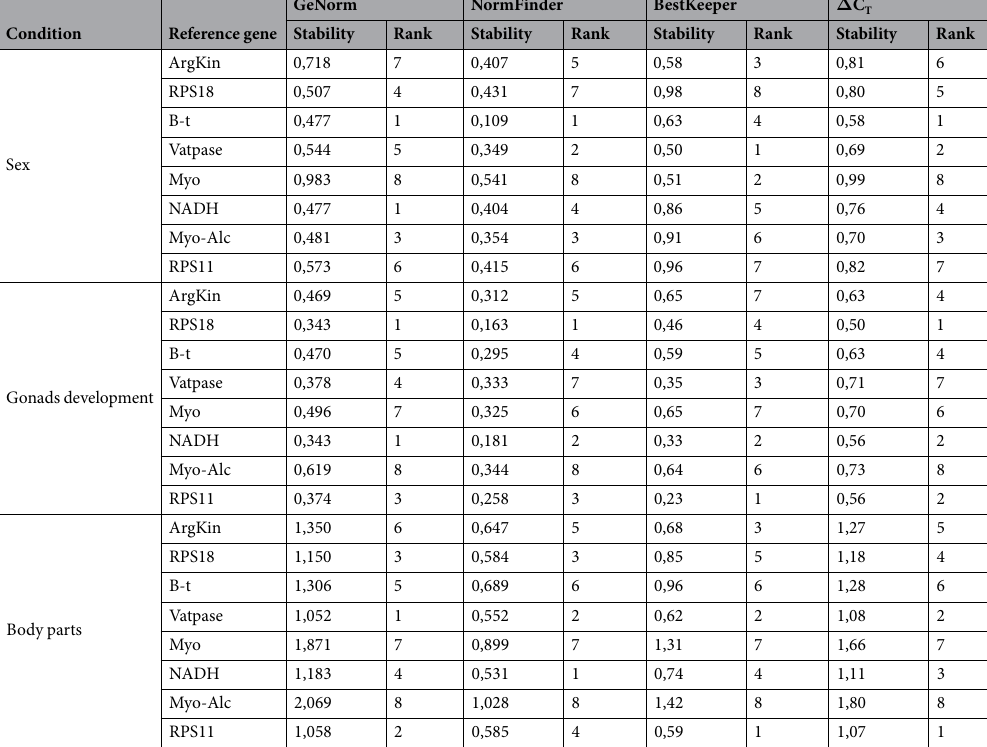
Table 2. Ranking of candidate reference genes based on stability values obtained with geNorm , NormFinder , Bestkeeper and Δ C T methods in C . campestris .